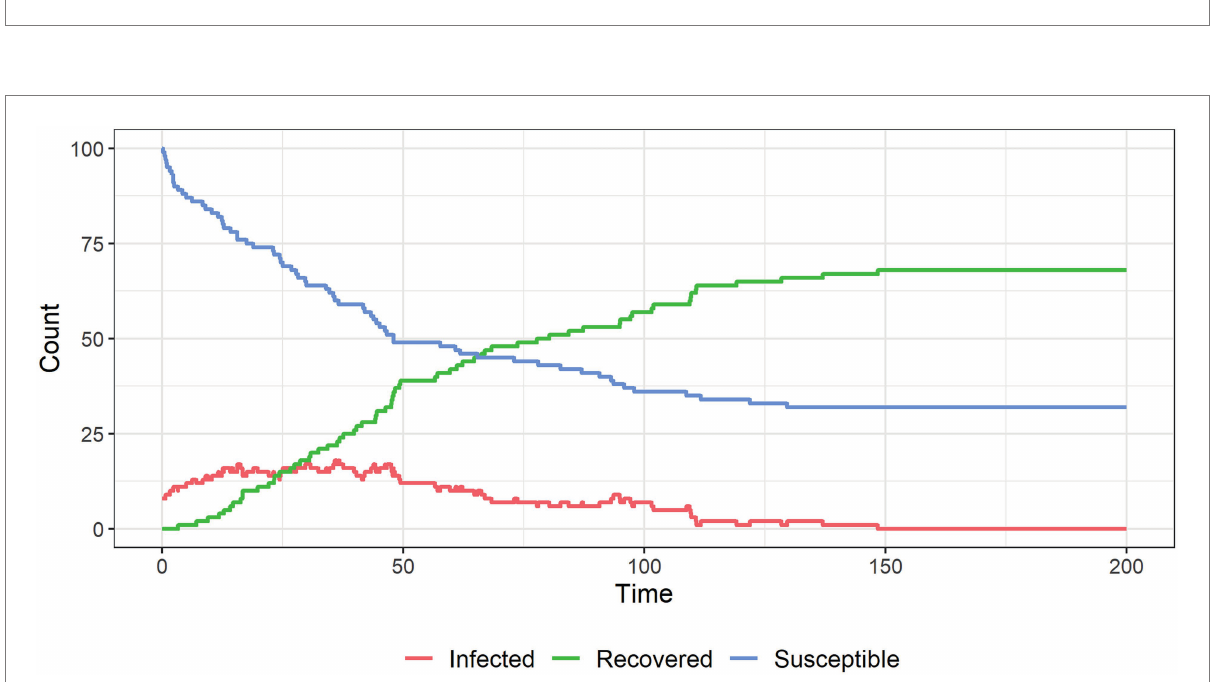
FIGURE 8 The spread of a conspiracy theory infection through a population, where believers cannot reinforce each other’s beliefs. The conspiracy theory dies out under these